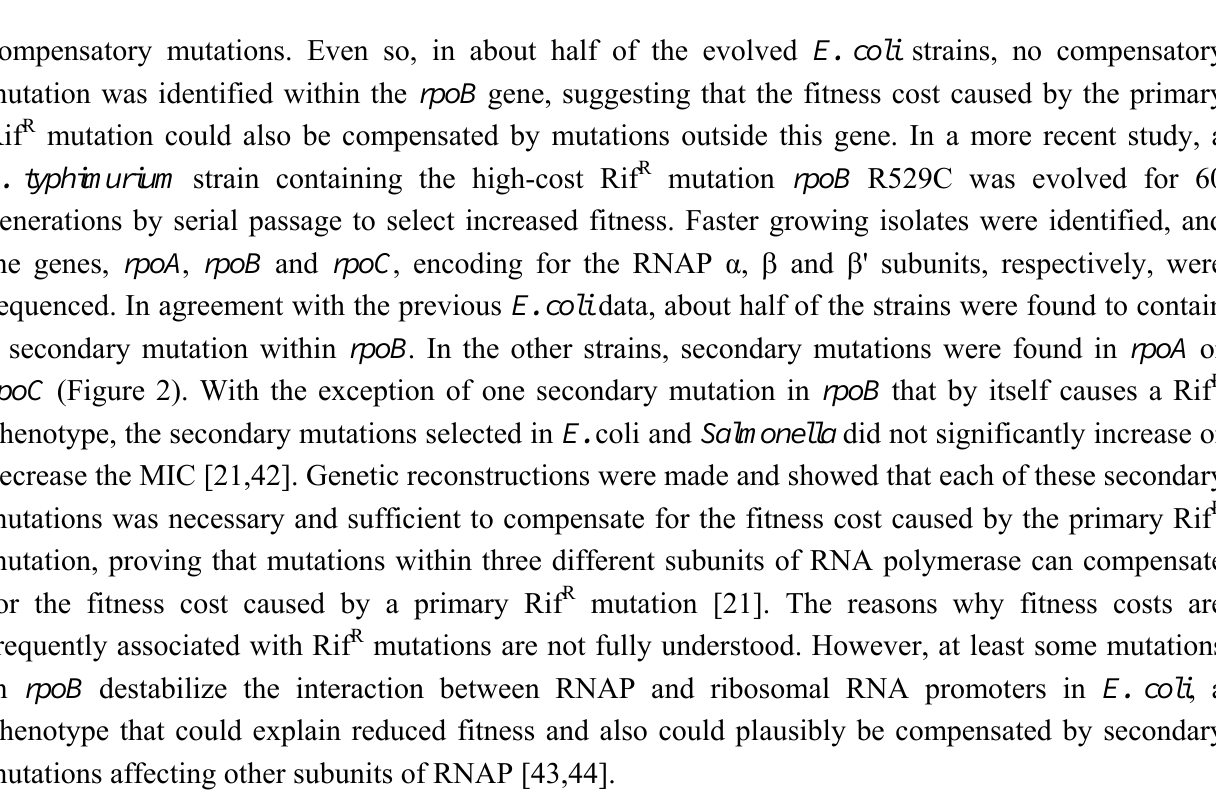
Figure 2. Fitness compensatory mutations that ameliorate the fitness costs of the rifampicin-resistance mutation, rpoB R529C, occur in rpoA , rpoB and rpoC genes, coding for different subunits of RNA